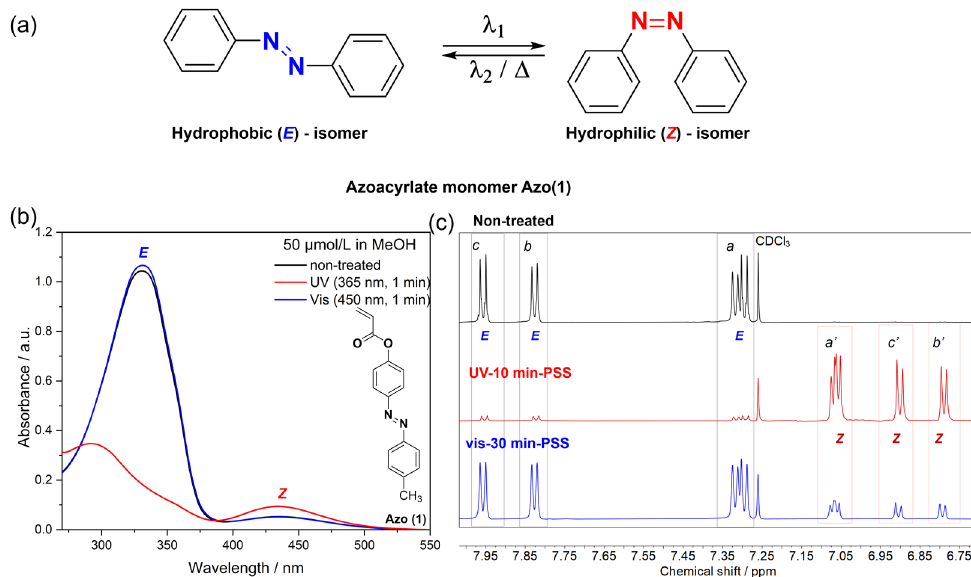
Figure 1. ( a ) Schematic diagram representing the light-induced reversible switching of azobenzene from the ( E ) to the ( Z ) isomer; ( b ) UV-vis spectra of the azoacrylate monomer, Azo(1) , in methanol (50 µmol/L), indicating reversible switching when irradiated with UV light (365 nm, 1 min) and vis light (450 nm, 1 min); ( c ) 1 H NMR spectrum of the Azo(1) monomer in CDCl 3 (4.88 mmol/L), indicating ( E ) isomer (>98%) in the non-treated form; mixture enriched with the ( Z ) isomer after irradiation with UV light (red) and back-switched to an ( E )-isomer-rich mixture upon irradiation with vis light (blue).